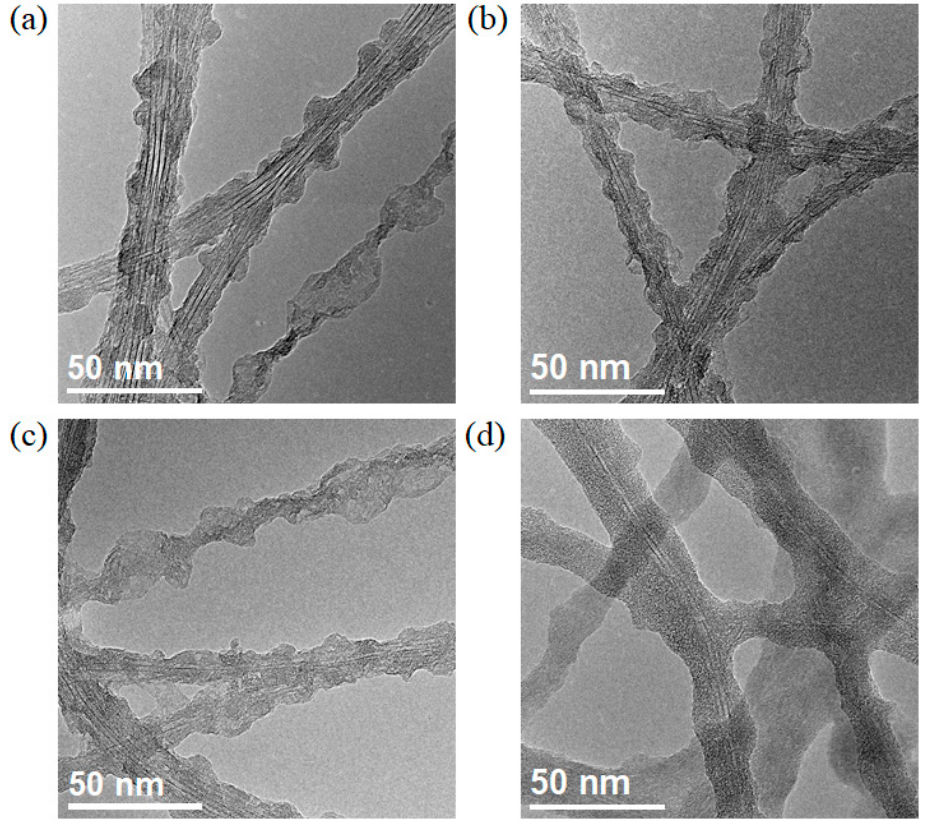
Figure 5. TEM images of the SWCNT@h-BN synthesized using SWCNTs experienced different plasma-treatment time as a template: ( a ) 20 s, ( b ) 40 s, ( c ) 60 s, and ( d ) 100 s.